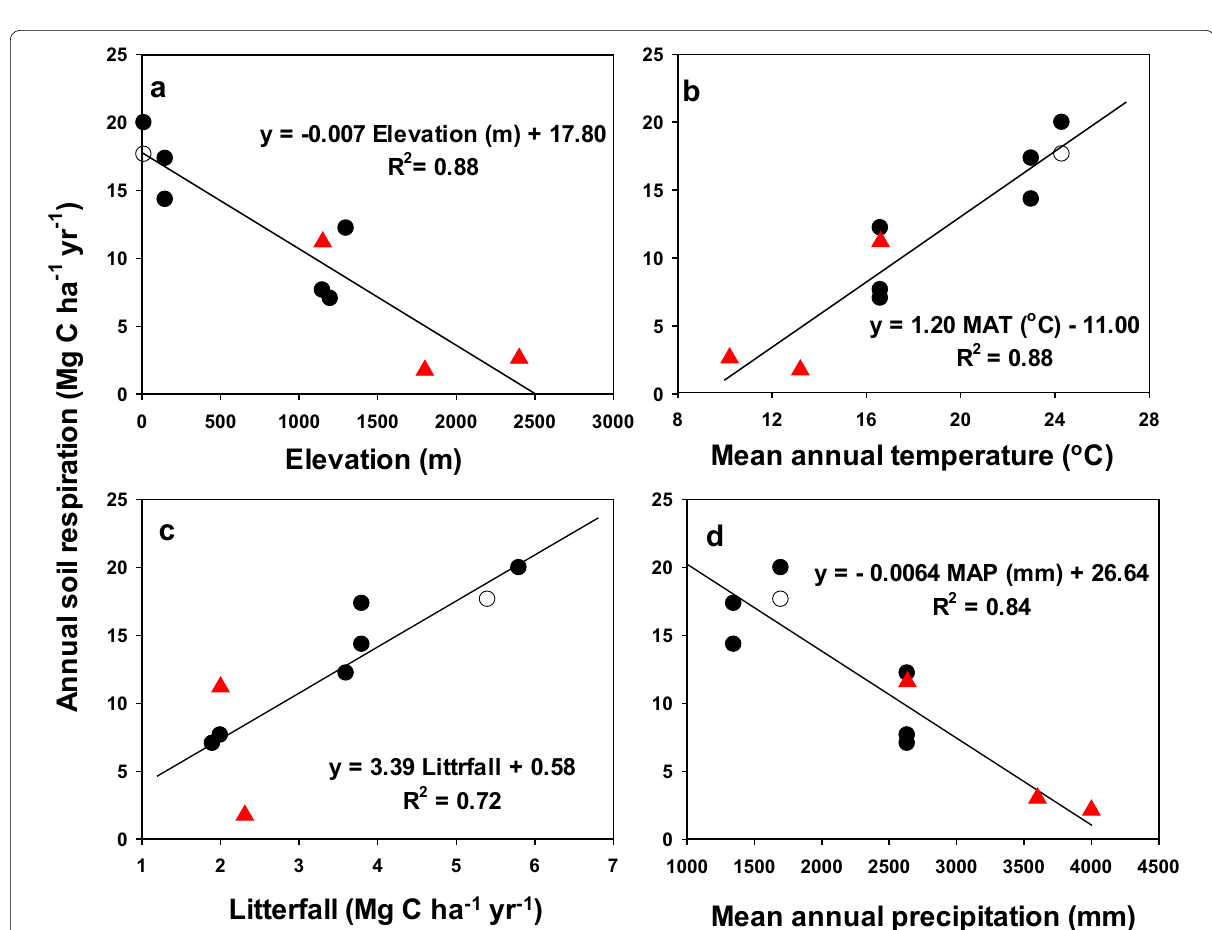
Fig. 4 Linear relationships of annual soil respiration with a elevation, b mean annual temperature, c litterfall, and d mean annual precipitation in Taiwan. Black circles refer to the current study and red circles refer to previous studies (Chang et al. 2008; Kao and Chang 2009; Hsieh et al.